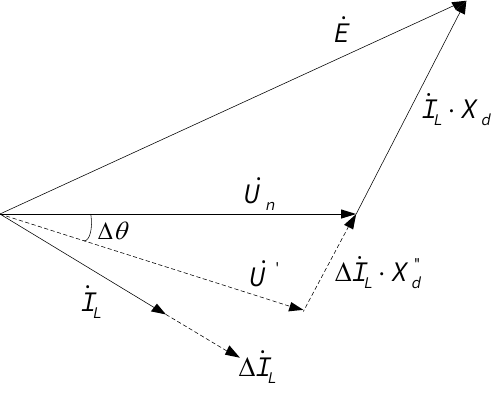
Figure 1. Voltage vector shift illustration.